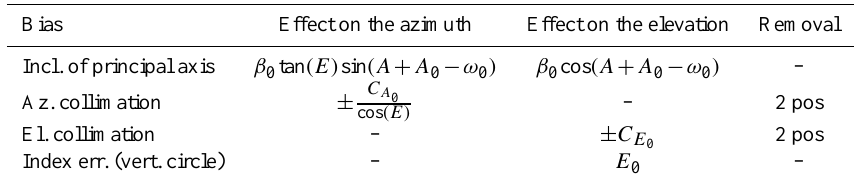
Fig. 1. Main instrumental errors: inclination of the principal axis ( β 0 , ω 0 ), collimation errors ( C A and the index default affecting the elevation angle ( E 0 ). The antenna drawing has been kindly provided by Prosensing Inc.